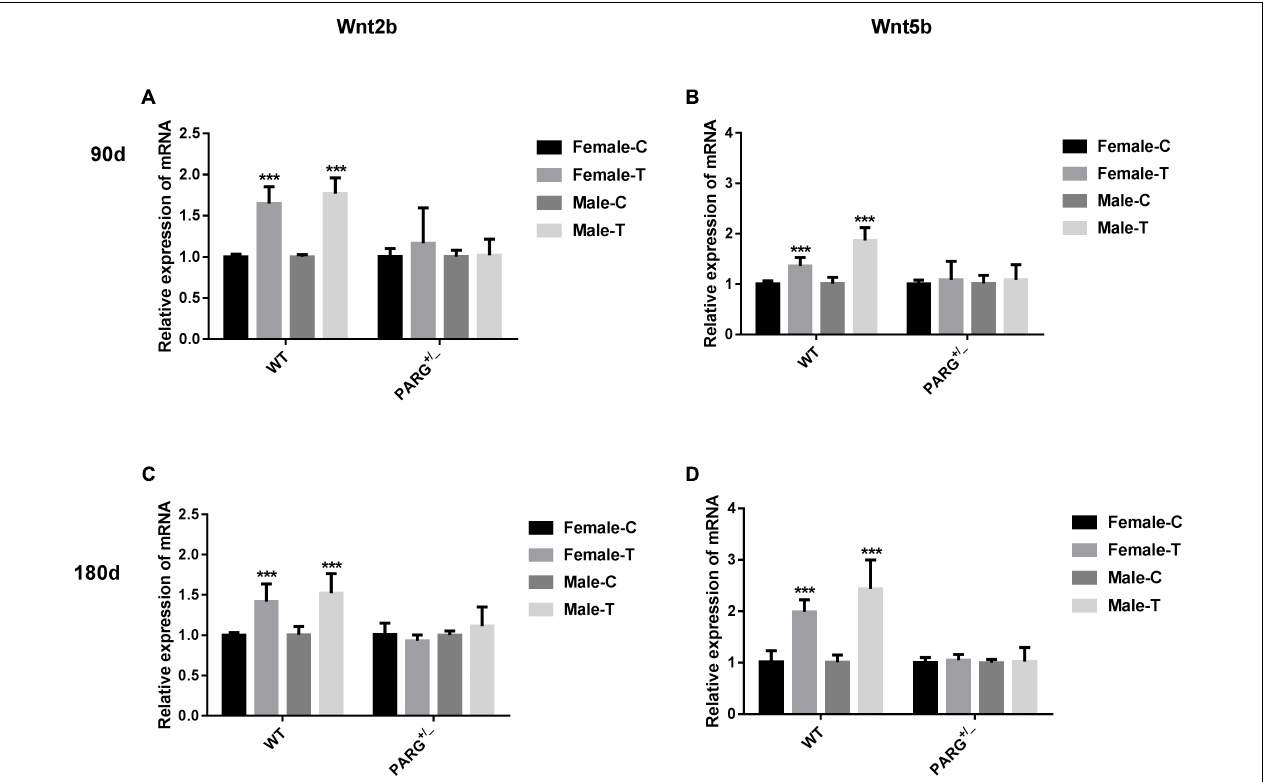
FIGURE 4 | PARG silencing inhibits the relative expression of Wnt2b and Wnt5b mRNA in lung tissues after BaP inhalation exposure. Relative expression of Wnt2b and Wnt5b mRNA in lung tissues of WT and PARG + / − mice after BaP inhalation exposure. The mRNA expression in lungs from WT and PARG + / − mice was measured by real-time quantitative PCR after 90 days (panels A , B ) or 180 days (panels C , D ) of BaP inhalation exposure. Female-C, control untreated female mice; Female-T, treated female mice; Male-C, control untreated male mice; Male-T, treated male mice. ∗∗∗ P < 0.001, significant difference was found in treated compared to untreated mice. Results represent the mean ± SD of 3 mice from each